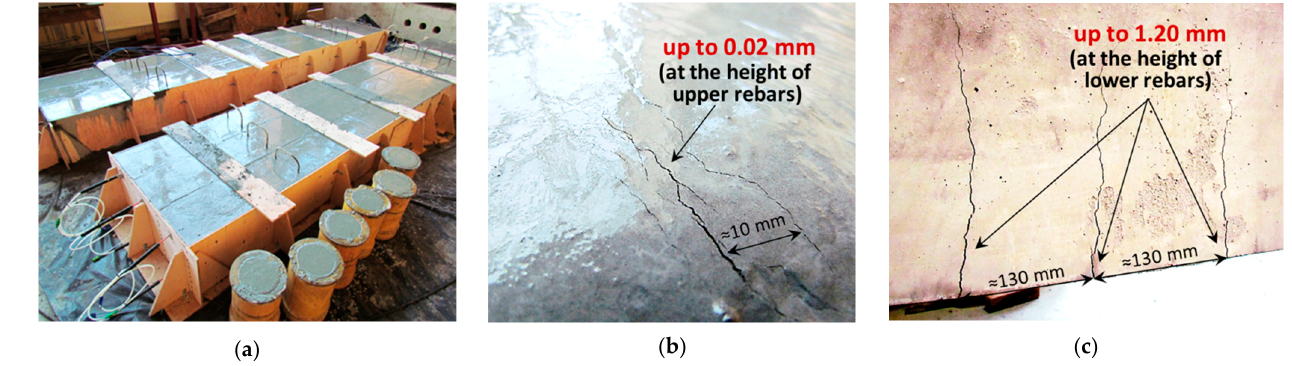
Figure 9. ( a ) The view of the beams after concreting; ( b ) thermal-shrinkage cracks within the upper part; ( c ) mechanical cracks within the lower part during bending tests.